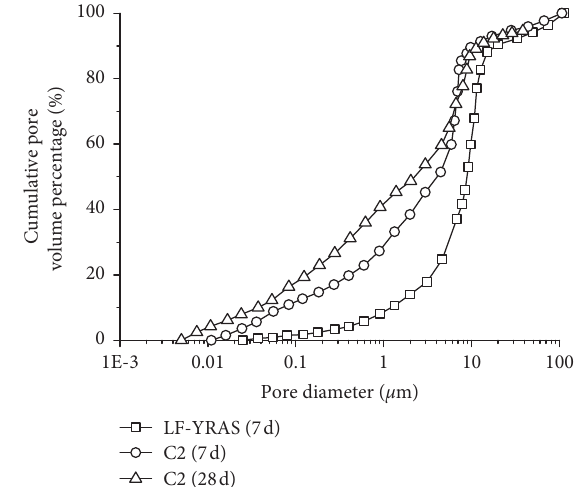
Figure 9: Cumulative pore volume percentage curve of LF-YRAS (curing for 7d), C2 (curing for 7d), and C2 (curing for 28d).